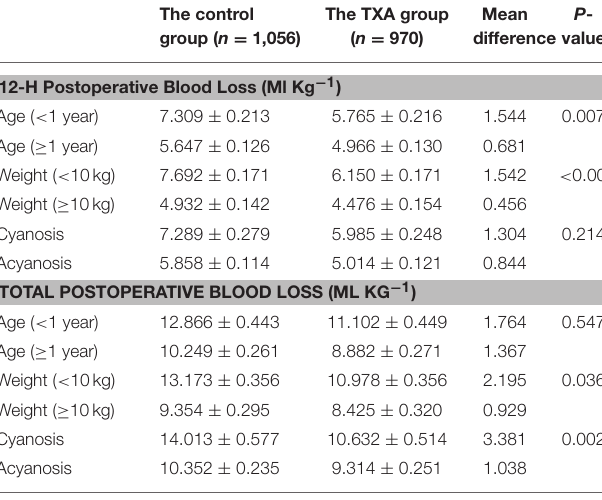
TABLE 3 | Interactions of postoperative blood loss with age, weight, cyanotic status, and administration of tranexamic acid. The control The TXA group group ( n = 1,056) ( n =